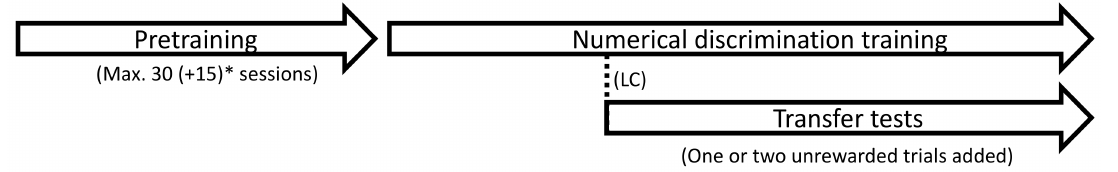
Figure 3. Schematic overview of the experimental timeline. After the successful “Pretraining” animals were transferred to a specific “Numerical discrimination training”. When reaching the LC within the numerical discrimination training, unrewarded transfer tests were implemented and added to the training. * Experimentally naïve individuals that did not reach the LC before the end of the 30th session, were given an additional 15 sessions after which their performance was